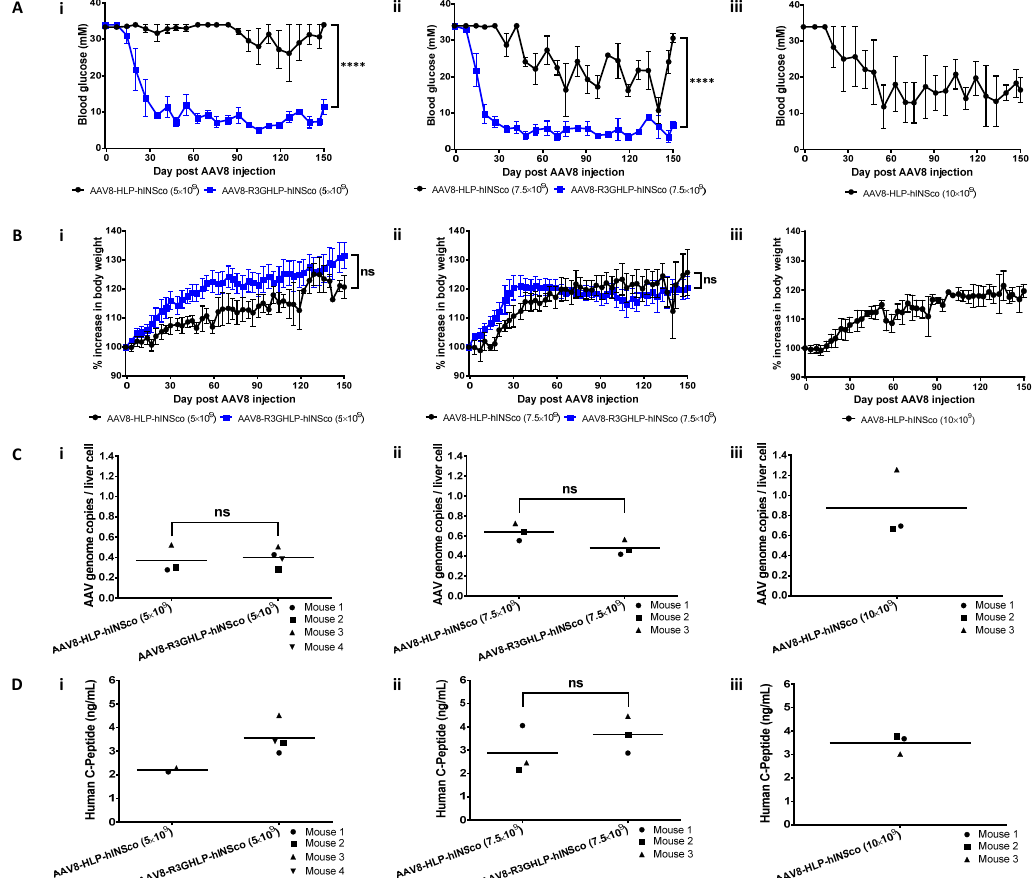
Figure 3. Treatment e ffi cacy and tolerability of AAV8-R3GHLP-hINSco on STZ-induced diabetic NSG mice at higher dose. Control non-glucose responsive AAV8 vector, AAV8-HLP-hINSco and glucose responsiveAAV8vector, AAV8-R3GHLP-hINScowereinjectedatvariousdosesat( i )5 × 10 9 , ( ii )7.5 × 10 9 and ( iii ) 10 × 10 9 (AAV8-HLP-hINSco only) vg / mouse. ( Ai – iii ) Blood glucose level post AAV8